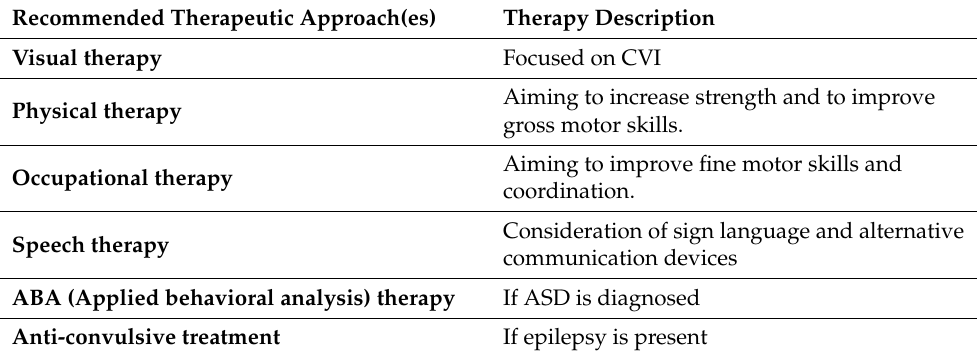
Table 4. Recommended therapeutic approaches. Table resuming the recommended therapeutic approaches for BBSOAS patients. Abbreviations: ASD, autism spectrum disorder; CVI, cortical visual